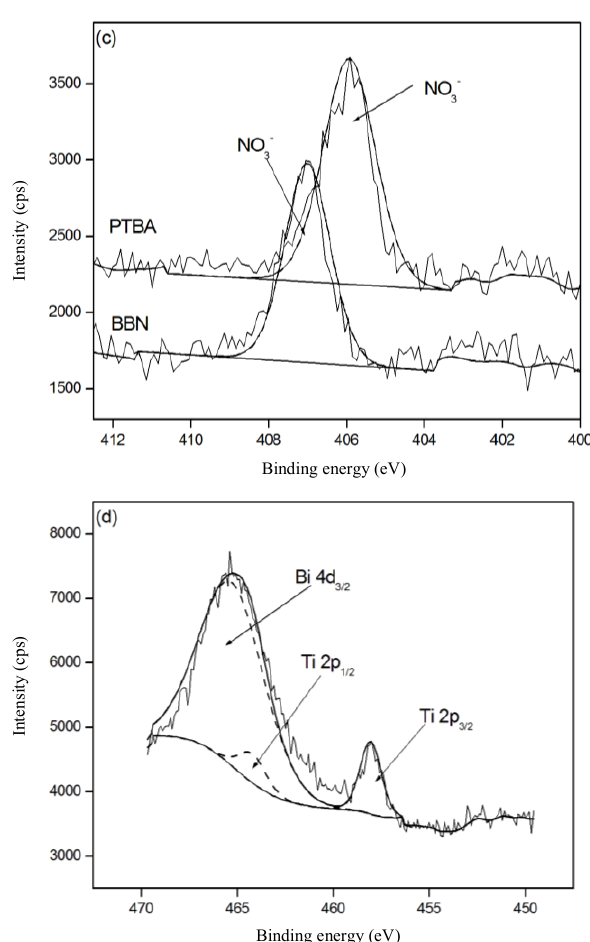
Figure 6. Deconvoluted XPS spectra of (a) Bi 4f (b) O 1s (c) N 1s and (d) Ti 2p regions of BBN and PTBA